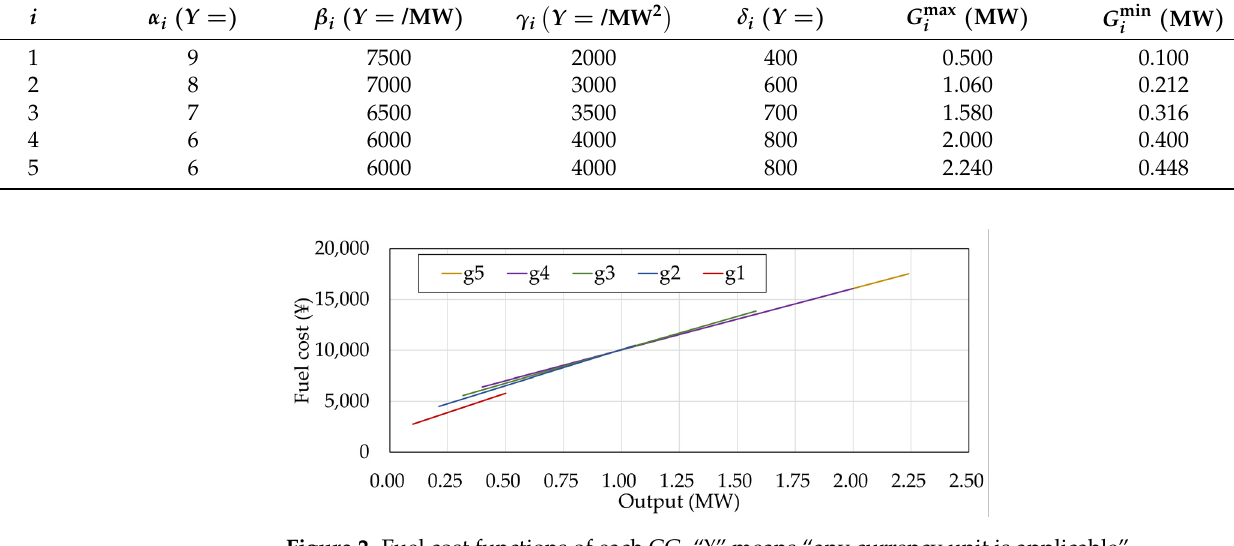
Figure 2. Fuel cost functions of each CG. “¥” means “any currency unit is applicable”.